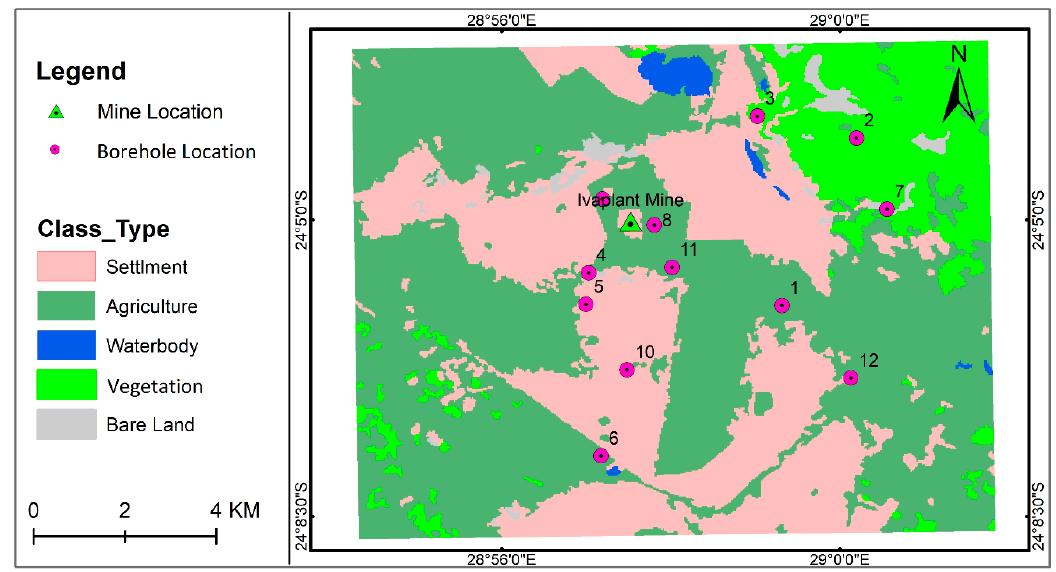
Figure 3. Land-use/land-cover (LULC) map based on Landsat 2018 by using maximum likelihood Figure 3. Land-use / land-cover (LULC) map based on Landsat 2018 by using maximum likelihood classification algorithm. classification